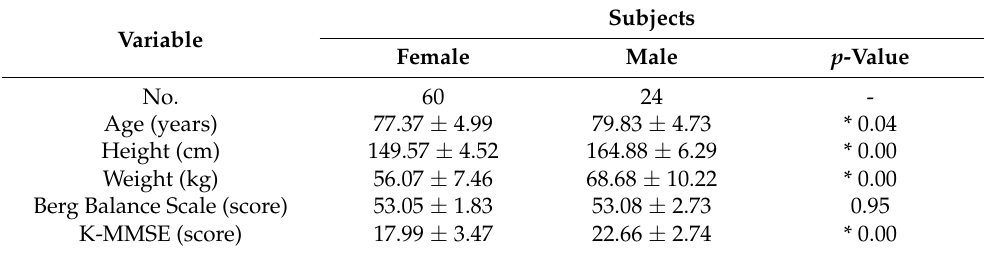
Table 1. Characteristics of the